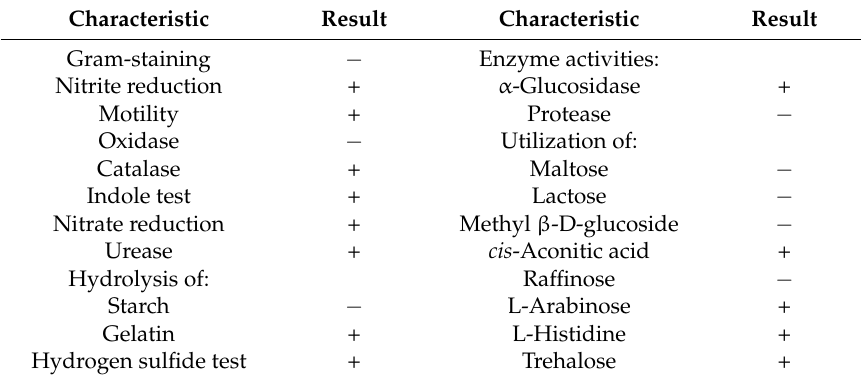
Figure 2. A maximum likelihood tree based on the 16S rRNA gene sequence of isolate YC801 and related representative strains. The scale bars indicate 0.05 substitutions per site. Sphingobacterium zeae (KU201960) was used as the outgroup. Table 1. Biochemical and physiological characteristics of the bacterial isolate YC801.